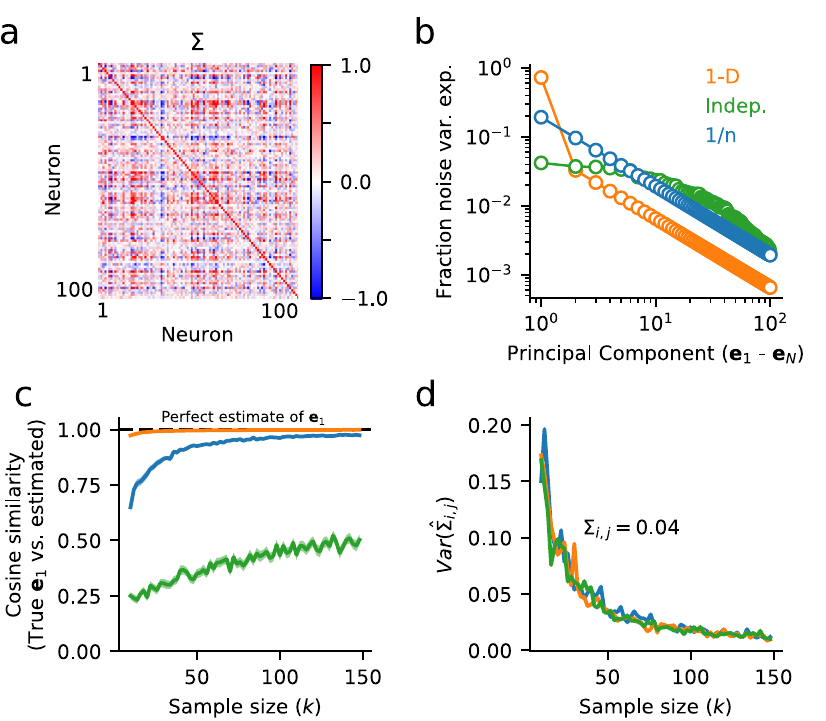
Fig 3. Low-dimensional noise correlation can be estimated reliably for neural populations, even when pairwise noise correlation cannot. a . Example covariance matrix, S , for a 100-neuron population with low-dimensional covariance structure. b . Scree plot shows the fraction of total population variance captured along each noise dimension, computed by PCA , for three different datasets with varying dimensionality. Orange: 1-dimensional noise (1-D), covariance matrix in (a); green: independent noise (Indep.); blue: power law decay (1/ n ). c . Surrogate datasets with varying numbers of samples, k , are drawn from the three noise distributions in (b). For each dataset, the cosine similarity between the estimate of the largest noise dimension, ^ e , and the true noise dimension, e 1 , is plotted as 1 function of sample size. For low-dimensional data, e 1 can be estimated very reliably. d . Variance in the estimate of covariance, S i , j , for two neurons with a true covariance of 0.04 is plotted as a function of the number of trials, as in Fig Þ � 0 : 02 , corresponding to a standard deviation of � 0.14. Therefore, estimates 2d. Even at sample sizes > 100, Var ð ^ S i ; j of S i , j , may be off by up to an order of magnitude. Note that the amount of uncertainty does not depend on the dimensionality of the data, and results for all three datasets overlap (see S1 Appendix for an analytical derivation).